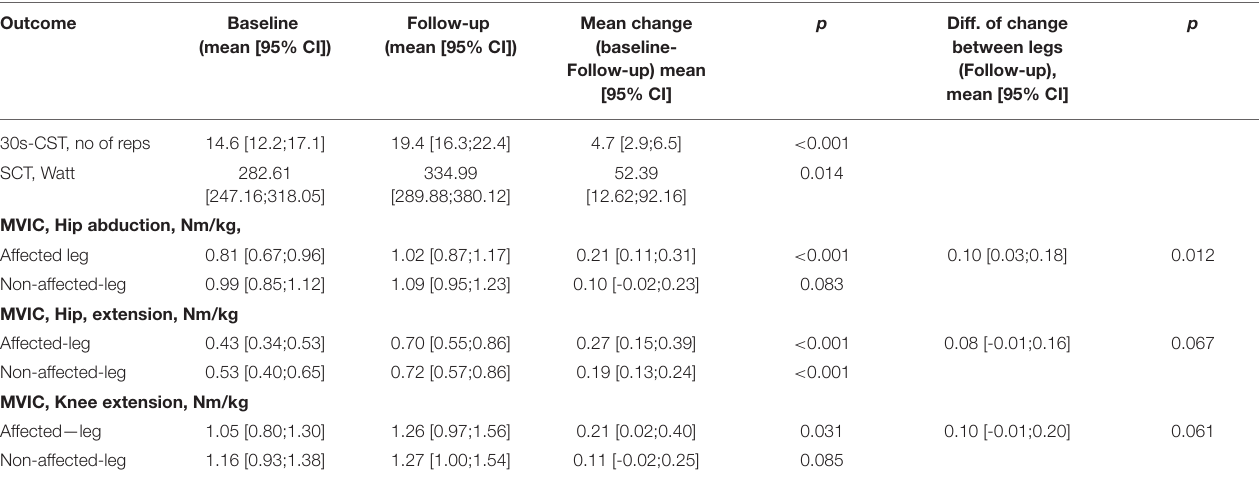
TABLE 3 | Performance-based outcomes and isometric muscle strength ( n =